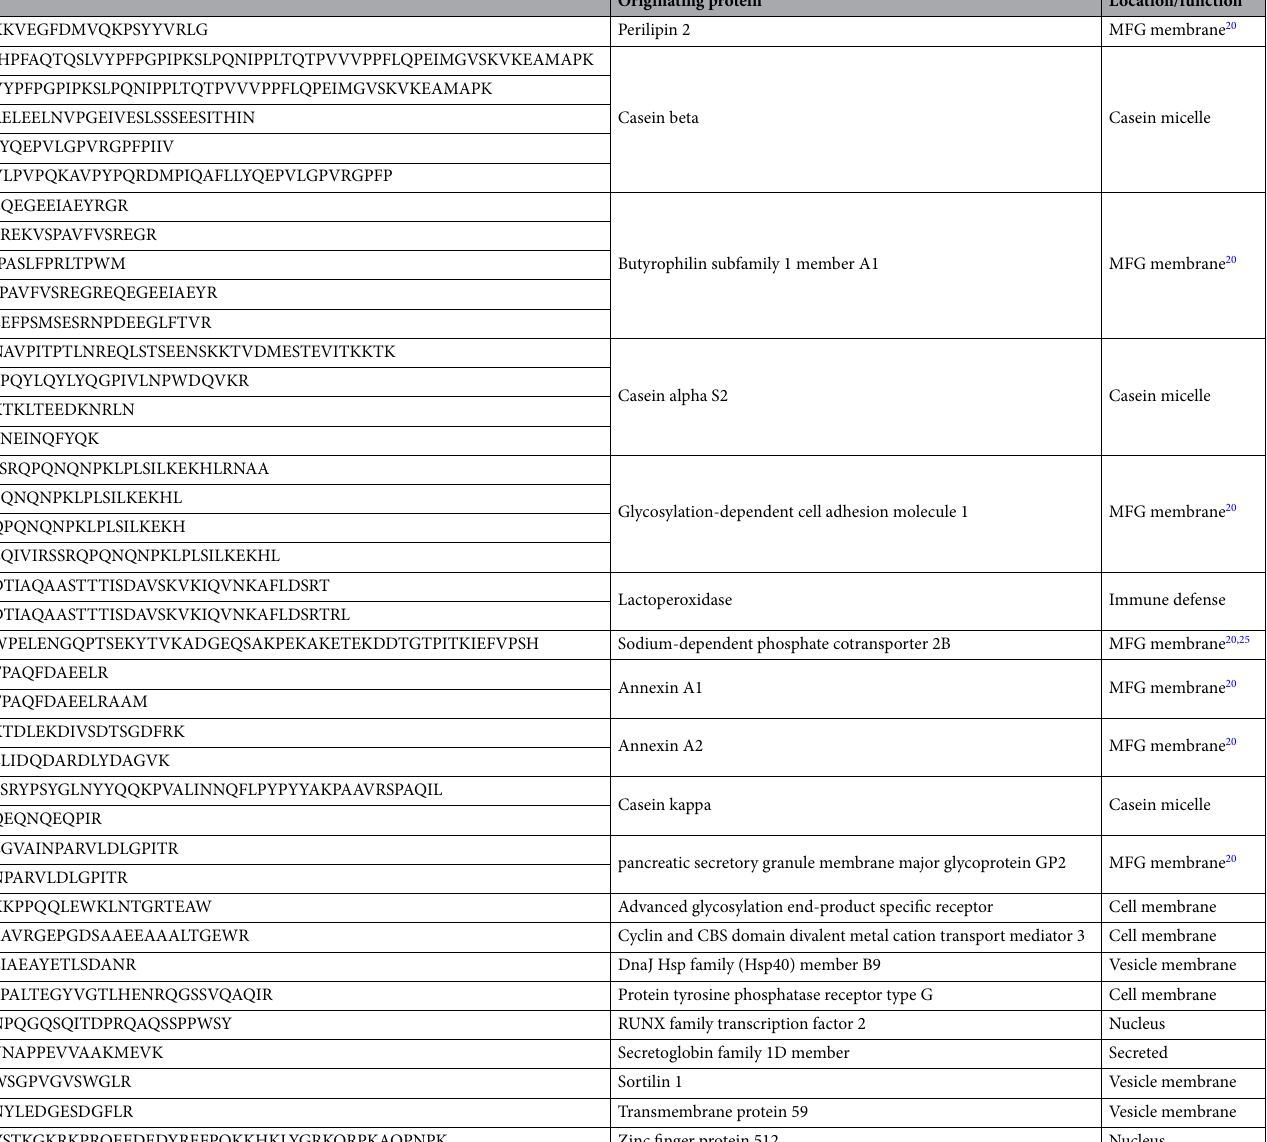
Table 3. Unique and significantly differential* peptides found in NAS-positive and healthy milk with the respective originating protein and its location/function according to the UniProtKB protein knowledge base or referenced literature sources, listed according to the originating protein and to the number of peptides derived from that protein. *Peptides significantly more abundant in the sample group according to the Welch t test with FDR ≤ 0.01. MFG milk fat